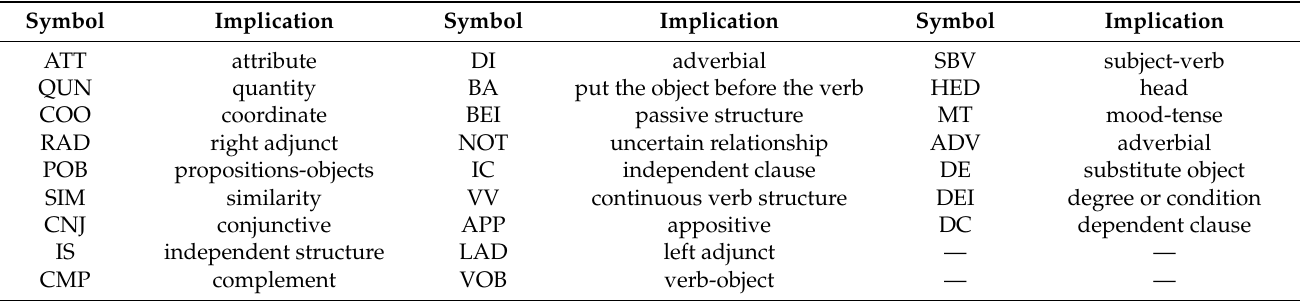
Table 1. Type of relationship for dependency